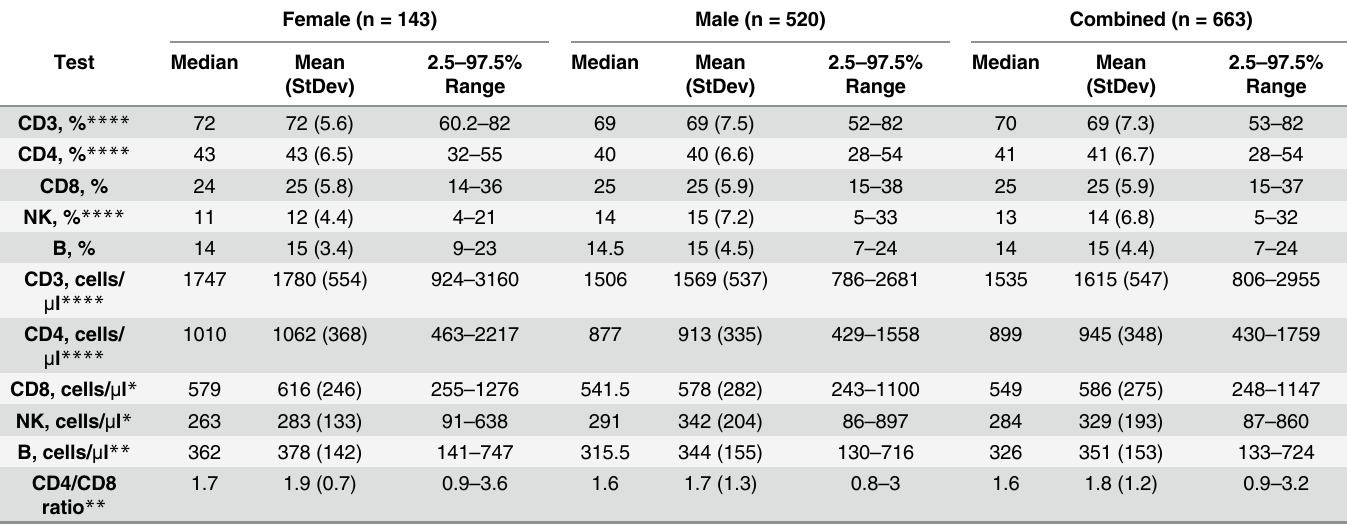
We next stratified the analysis by sex, and compared lymphocyte parameters across the three distinct cohorts. Urban male vaccine study participants had a significantly higher per- centage of cells expressing CD3 (median of 73 versus 69%), and CD4 (median of 44 versus 40%), and CD4/CD8 ratio (median of 1.85 versus 1.61) compared to semi-urban male blood bank participants (Table 3, p < 0.001, respectively) but significantly lower percentage of NK cells (Table 3, median of 10 versus 14%, p < 0.001) and lower absolute counts of cells expressing